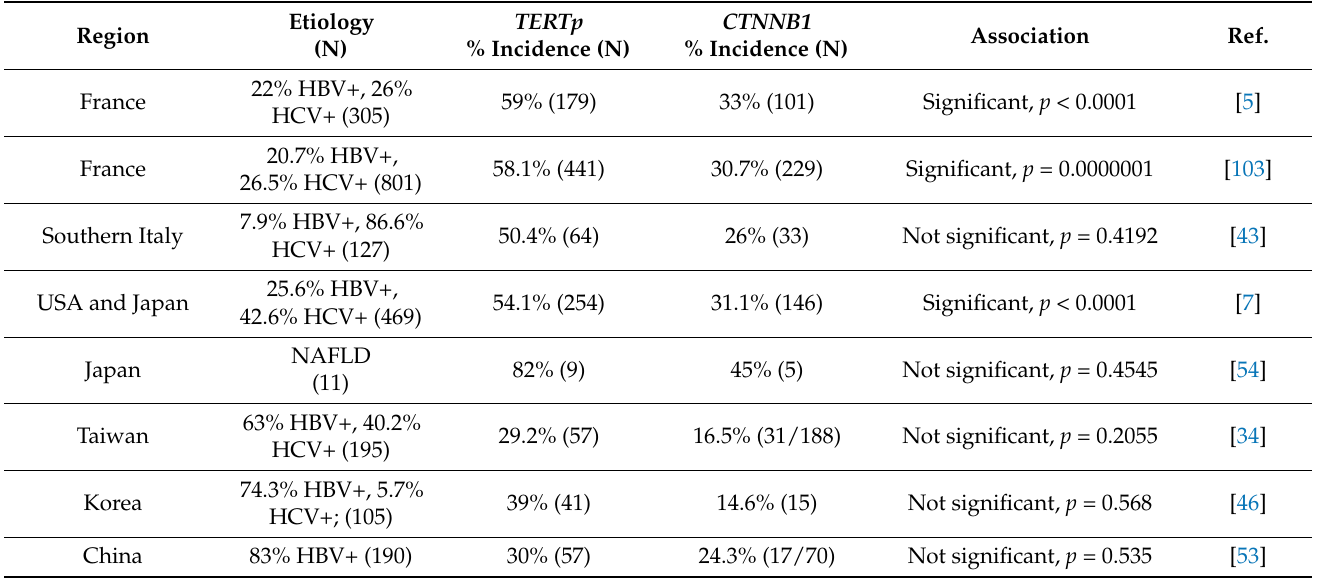
Table 4. Concordance between TERTp and CTNNB1 mutations in HCC: clues from clinical